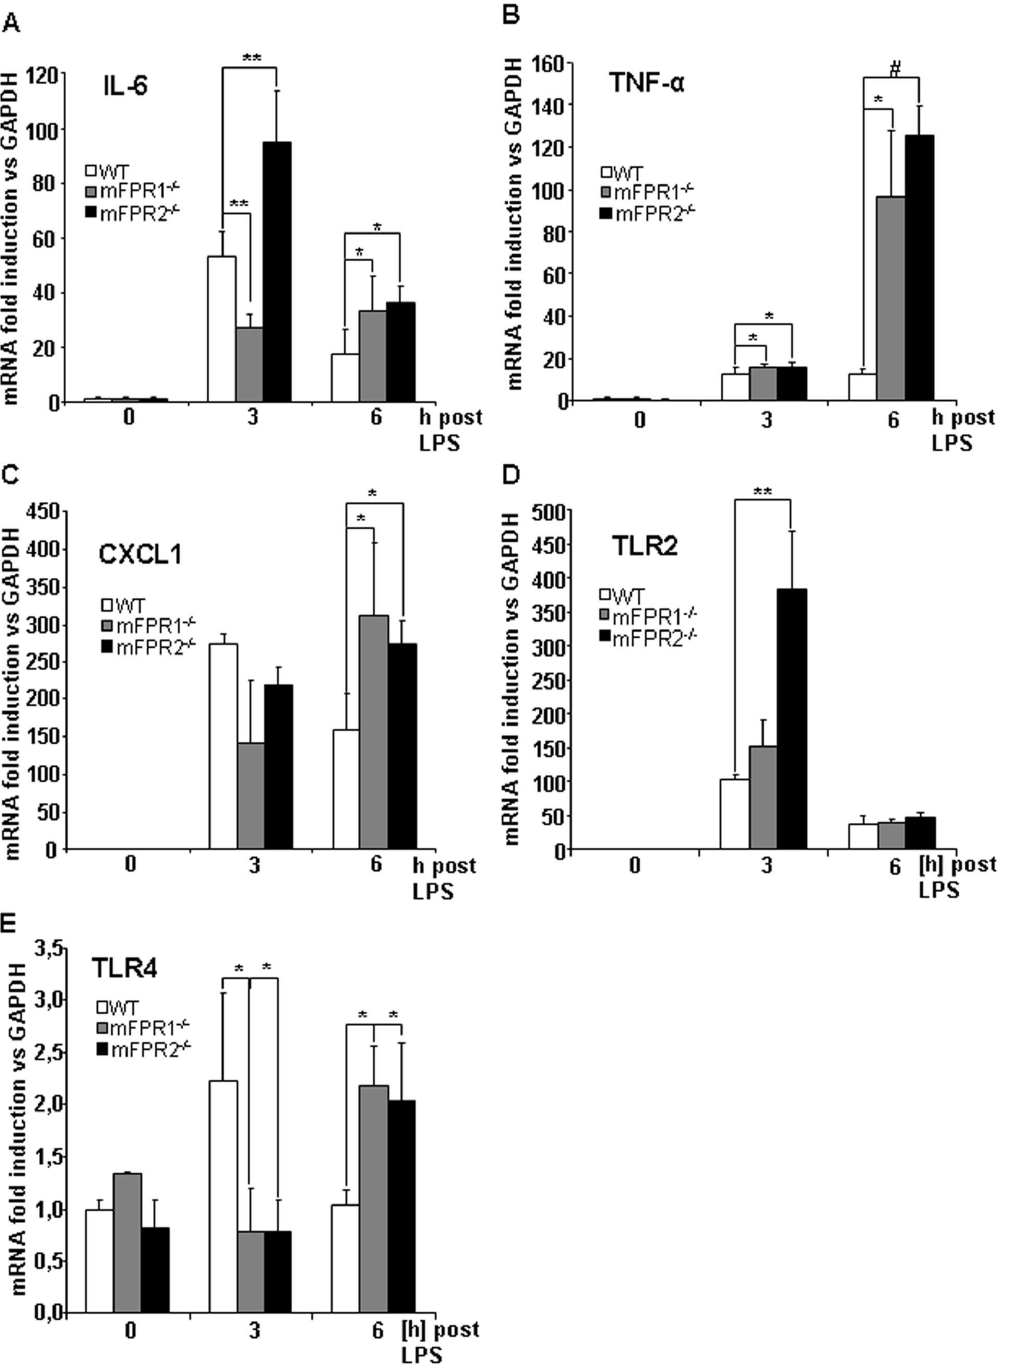
Figure 4. To better understand mechanism underlying the infiltration of immune cells into the liver of mFPR-deficient mice the gene expression of the pro-inflammatory cytokines IL-6 (A), TNF- a (B), CXCL1 (C), TLR2 (D) and TLR4 (E) were analyzed by qPCR. Changes in gene expression were related to GAPDH as a housekeeping gene. (*=p , 0.05; **=p , 0.01; # =p , 0.0001.) doi:10.1371/journal.pone.0100522.g004 of the staining revealed a lower number of Ki67 + -nuclei in the liver of either mFPR1 or mFPR2-deficient mice in comparison to wild type mice (Fig. 7 A and B). At 3 h mFPR1 -/- (0,89%) and mFPR2 -/- (1,19%) displayed a significantly lower number of proliferative cells compared to WT mice (1,47%) (mFPR1 -/- vs WT p , 0.01, mFPR2 -/- vs WT; p , 0.05). At 6 h post LPS